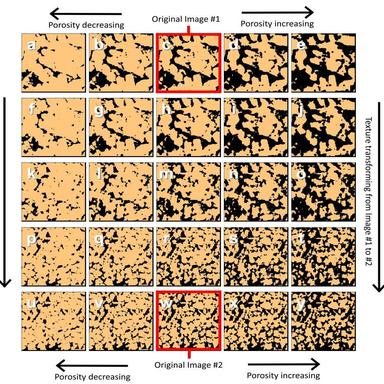
Texture interpolation results based on two real tomography images with a wide range of porosity and texture distributed between two original samples (d and w), porosity of the samples increases from left to right and texture is transforming from c to w when moving downwards.